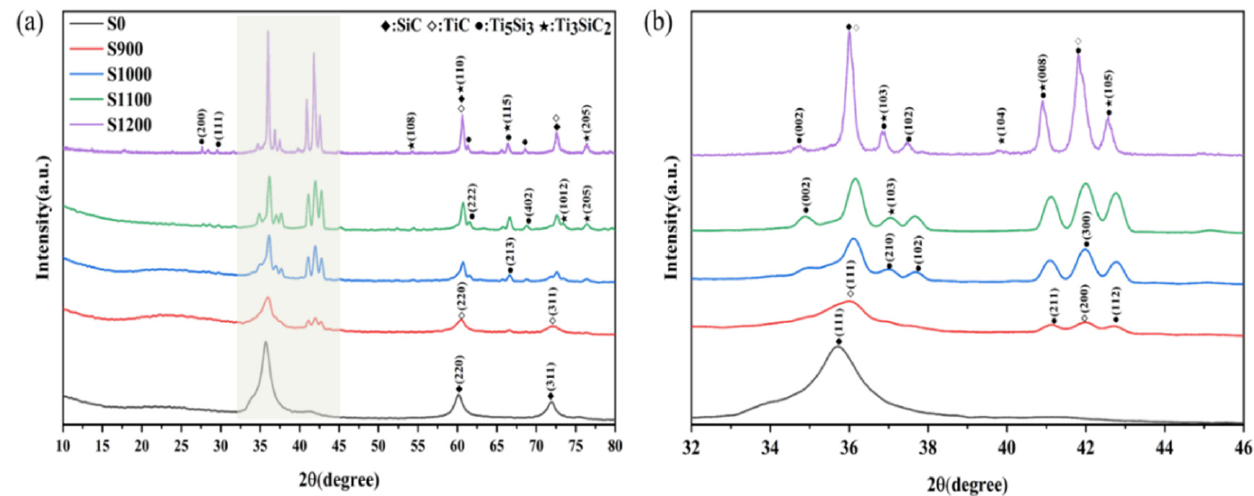
Figure 1. XRD (X-ray diffraction) patterns of SiC fiber tows coated with Ti 3 SiC 2 : ( a ) 10–80°; ( b ) 32–46°.